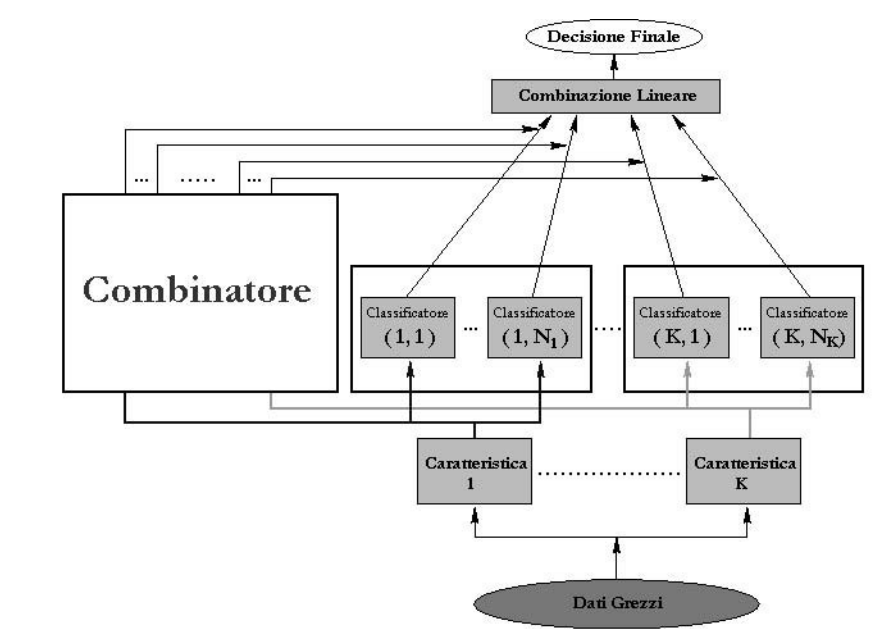
Figura 3 – Schematizzazione di C OMBY , la procedura meta-analitica da noi implementata (adattato da Chen e Chi, 1998 b ). Come si può vedere essa prevede l’estrazione di K differenti vettori di caratteristiche (nel nostro caso 12 CEPS , 12 MEL - CEPS e 12 LPC (cid:198) K = 3) dallo stesso insieme di dati e l’utilizzazione di N dei quali addestrati sulla base del k -esimo insieme di caratteristiche. Il combinatore classificatori, N k provvede infine a ponderare opportunamente ciascuna combinazione classificatore –